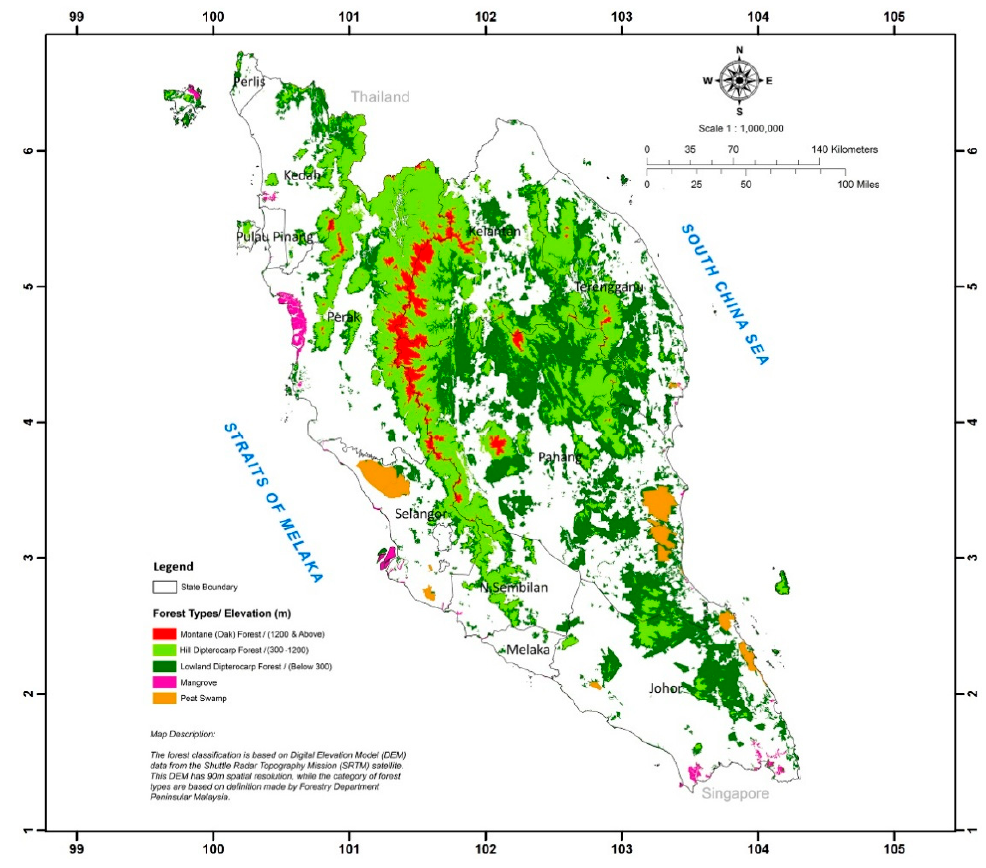
Figure 1. Forest types in Peninsular Malaysia.